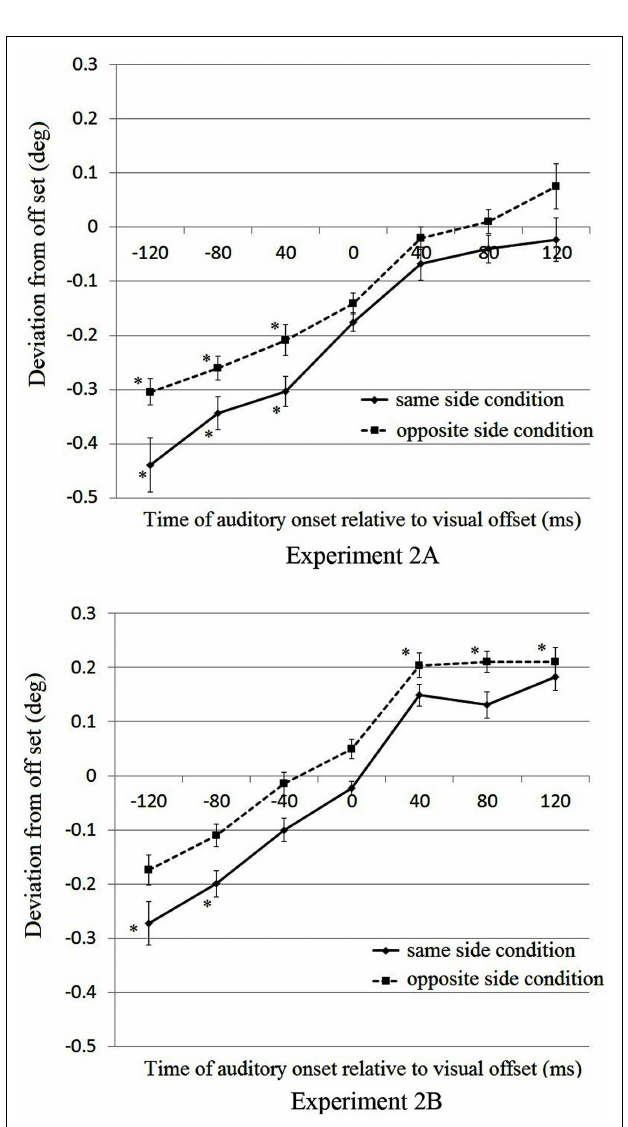
FIGURE 3 | Results of Experiments 2A (top) and 2B (bottom). The horizontal and vertical axes represent, respectively, the different sound presentation conditions and the perceived deviation from the physical visual offset position in degrees of visual angle. A negative value in the deviation from visual offset ( Y -axis) means that the perceived visual offset position was behind the actual visual offset position. Error bars represent within-participants SEMs (Loftus and Masson, 1994; Cousineau, 2005) for each presentation. Data points with an * mark indicate that the perceived positions differ from